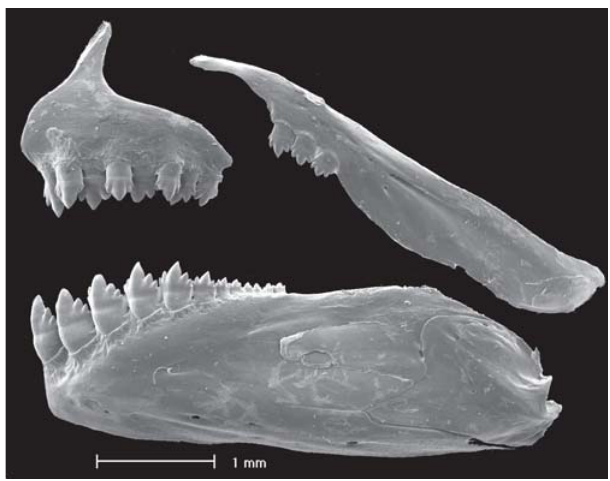
Fig. 2. Hyphessobrycon hexastichos , MCP 37649, paratype, 38.8 mm SL. Scanning electronic microscopy of left side up- per and lower jaws